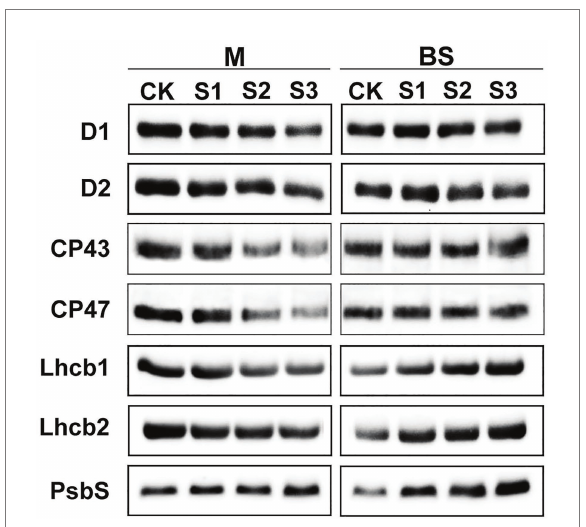
FIGURE 6 Steady-state levels of PSII proteins in M and BS thylakoids of maize leaves under drought stress. Immunoblot analyses of PSII proteins in M thylakoids (1.0 μ g Chl) and BS thylakoids (1.5 μ g Chl) were performed using antibodies specific for D1, D2, CP43, CP47, Lhcb1, Lhcb2, and PsbS. The results shown are representative of those obtained in at least three independent experiments. CK, S1, S2, and S3 represent, respectively, the well-watered, mild drought, moderate drought and severe drought